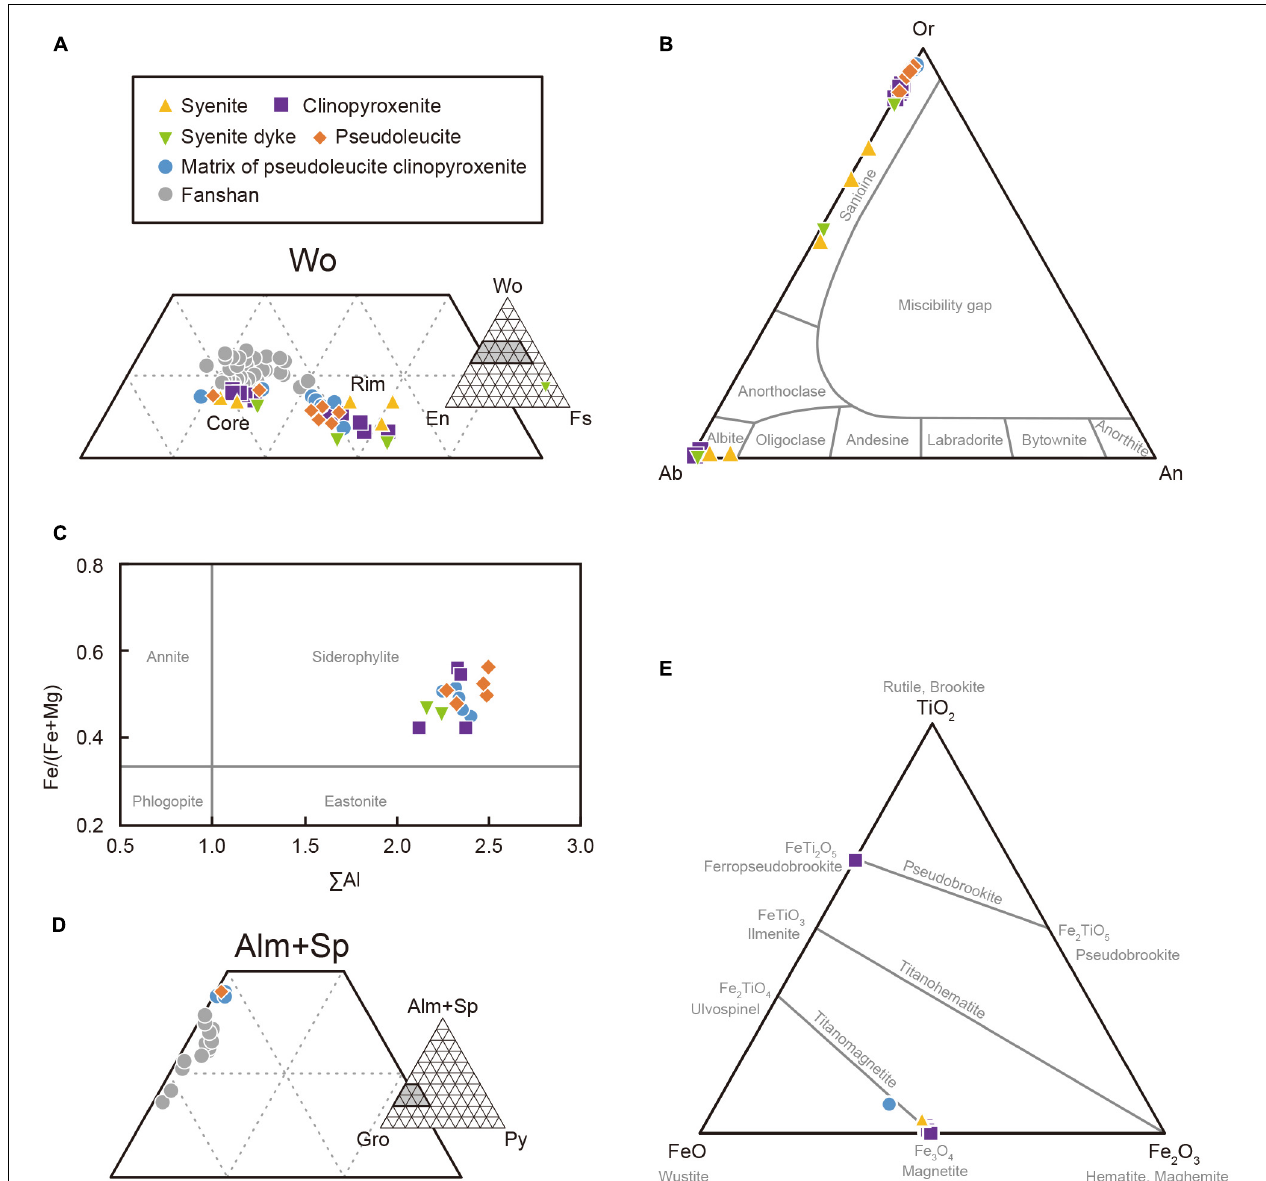
FIGURE 11 | Compositional variation of major minerals from Yaojiazhuang complex. (A) Clinopyroxene; (B) K-feldspar with exsolved albite lamellae; (C) biotite; (D) garnet; (E) TiO 2 –FeO–Fe 2 O 3 ternary system (after Buddington and Lindsley, 1964). Data of clinopyroxenes and garnets from Fanshan ultrapotassic complex (Hou et al., 2015) are plotted for